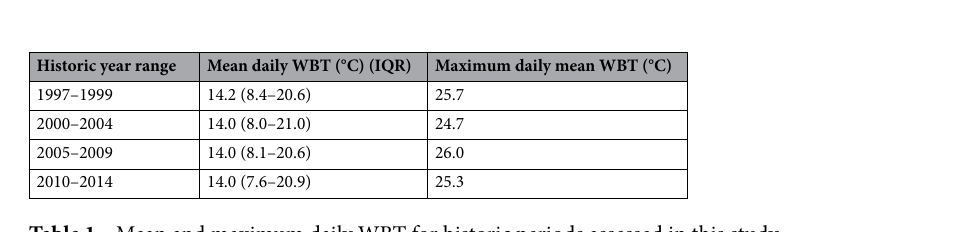
Table 1. Mean and maximum daily WBT for historic periods assessed in this study.